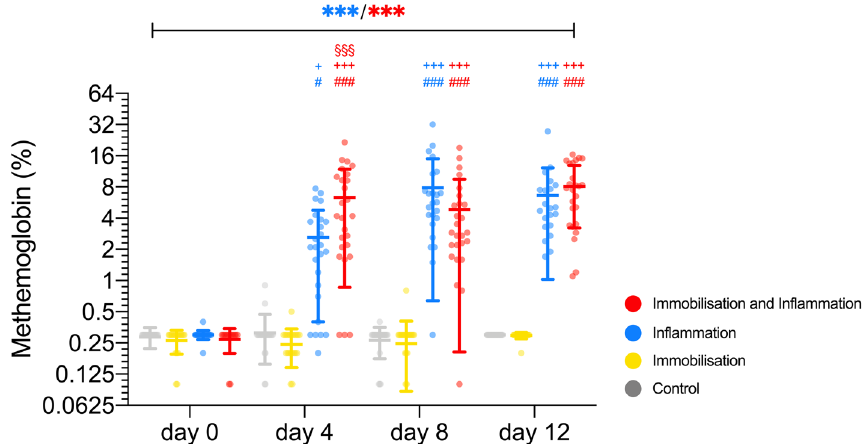
Fig. 2 Methaemoglobin (MetHb) blood levels in %. The control (mean [SD]; day 0: 0.29 [0.06], day 4: 0.31 [0.16], day 8: 0.26 [0.09], day 12: 0.30 [0.00]; p 0.380) and immobilisation (mean [SD]; day 0: 0.26 [0.08], day = 4: 0.25 [0.09], day 8: 0.25 [0.16], day 12: 0.30 [0.02]; p 0.293) group showed no change in methaemoglobin = blood levels over time while in the inflammation (mean [SD]; day 0: 0.28 [0.08], day 4: 2.65 [2.31], day 8: 7.07 [5.73], day 12: 6.50 [5.09]; p < 0.001) as well as immobilisation and inflammation (mean [SD]; day 0: 0.28 [0.05], day 4: 6.22 [5.57], day 8: 4.77 [4.62], day 12: 8.06 [4.75]; p < 0.001) groups a significant increase over time was present. This led to significantly increased values in the inflammation group in comparison with the control and immobilisation group on day 4 ( p 0.035/p 0.027) as well as on day 8 ( p < 0.001 for both groups) and = = 12 ( p < 0.001 for both groups). The immobilisation and inflammation group showed an increase over all three other groups on day 4 ( p < 0.001 for all three groups) and over the control and immobilisation groups on day 8 ( p < 0.001 for both groups) and 12 ( p < 0.001 for both groups). The scale of the y-axis has